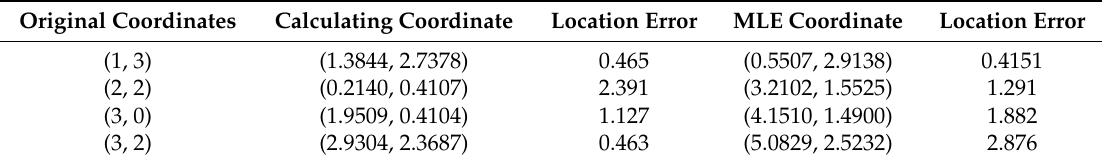
Table 10. Calculation results and error of unknown